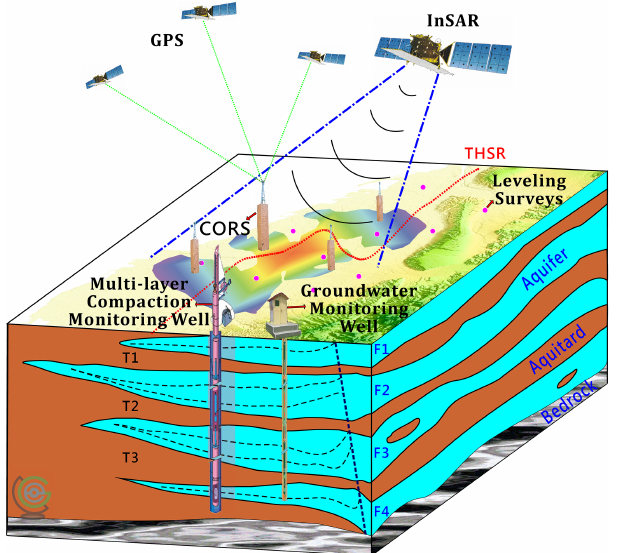
Figure 3. A conceptual picture of the multi-sensor land subsidence monitoring system in central Taiwan.